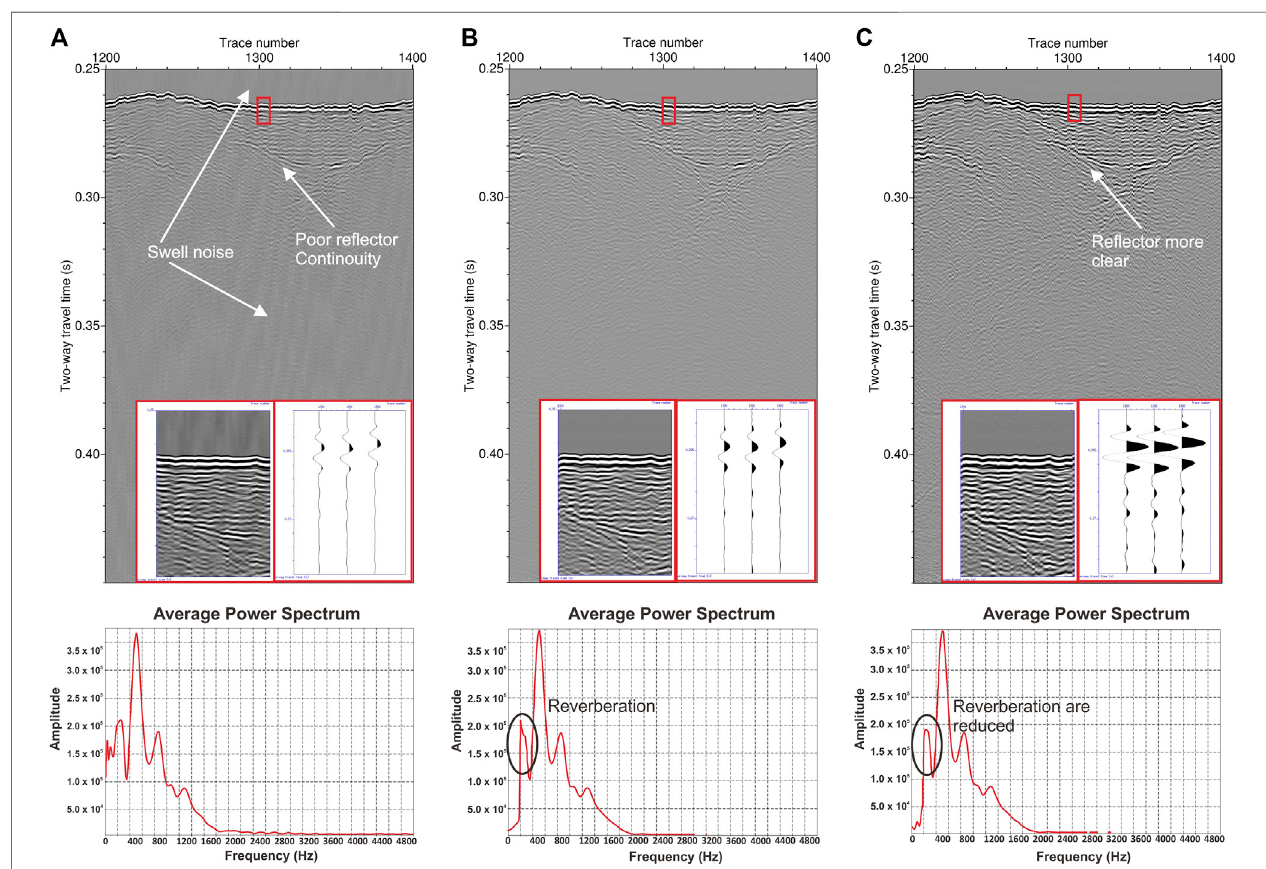
FIGURE 3 | Seismic Processing section from Pro fi le SKC-05A 2019. (A) Raw data with spectrum amplitude. (B) Data applied bandpass fi lter with window 180, 200, 1800, and 2000 Hz. (C) Deconvolution and spherical divergence applied.